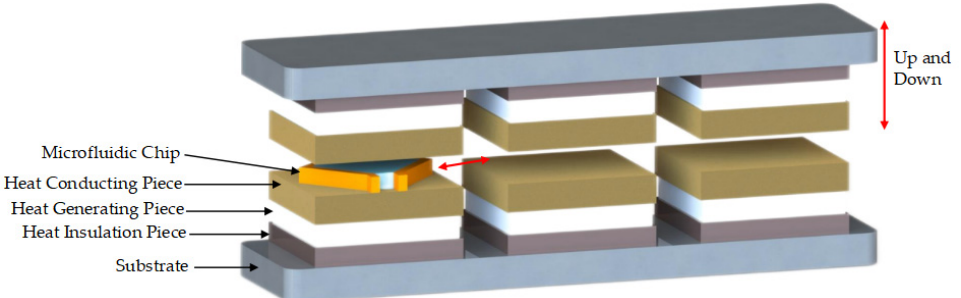
Figure 1. Ultrafast thermocycler scheme.